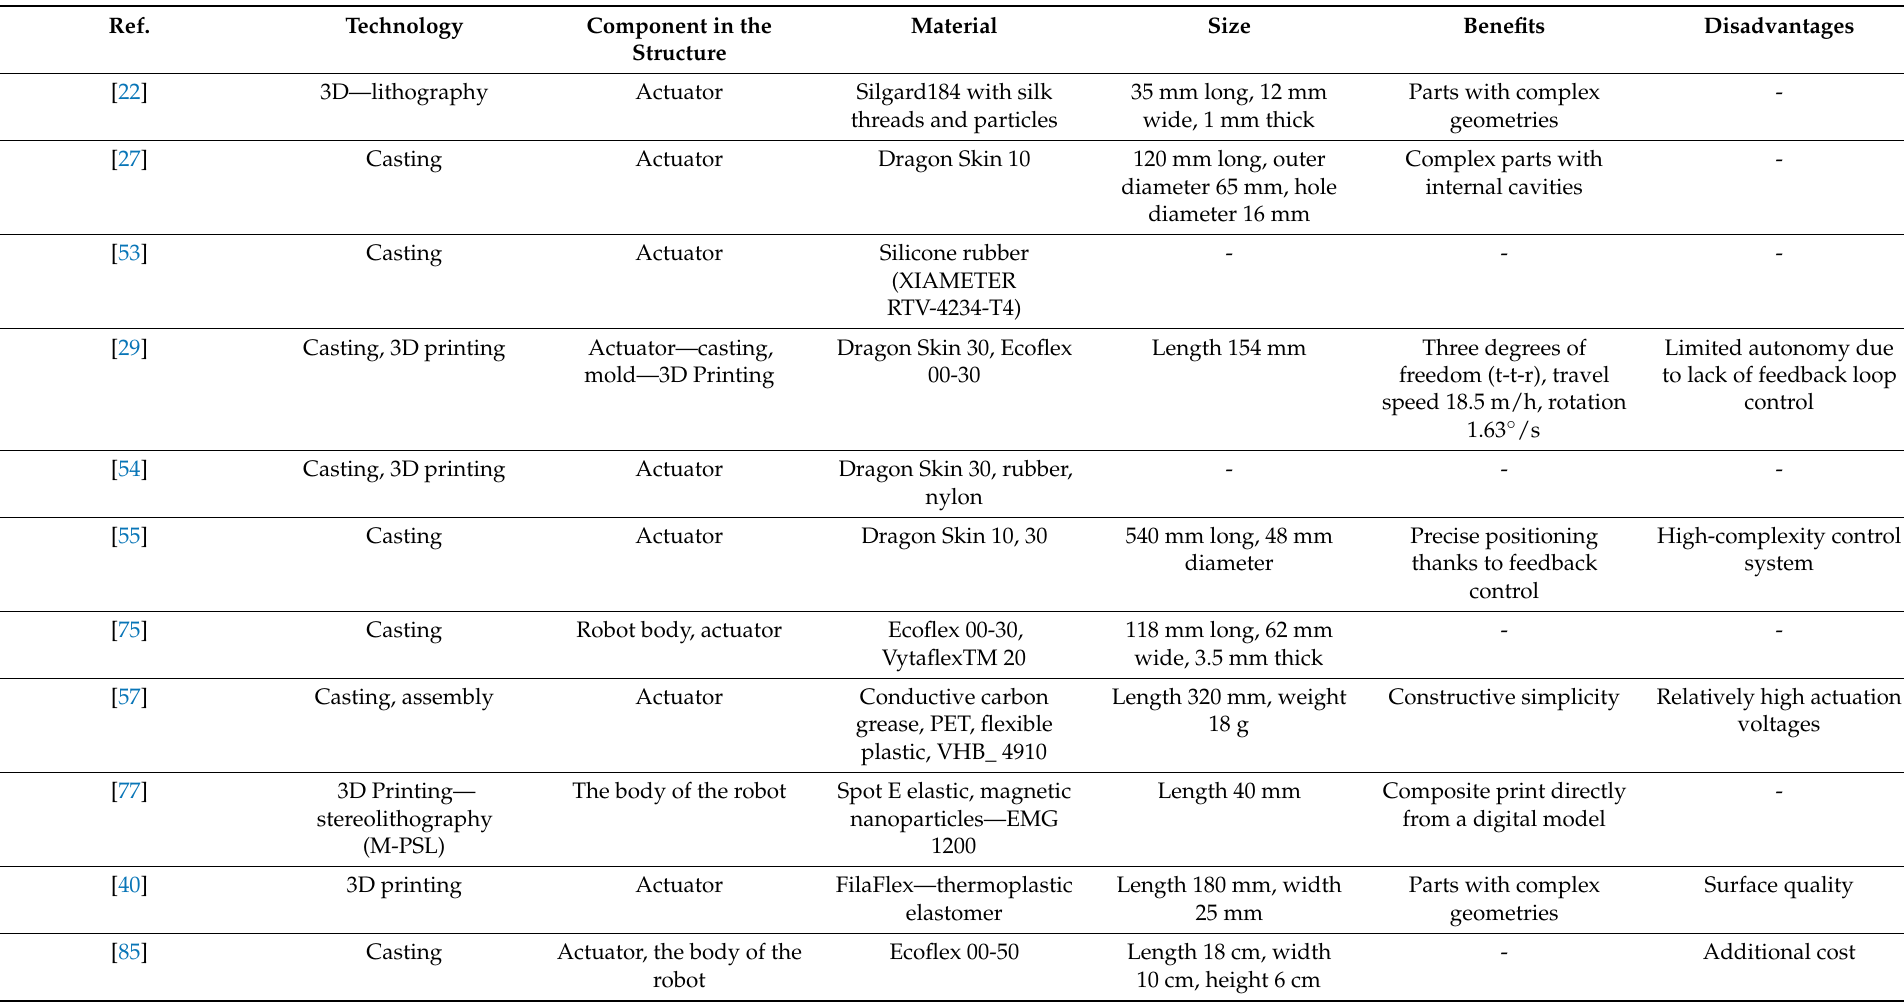
Table A4. Analysis of references according to the specific